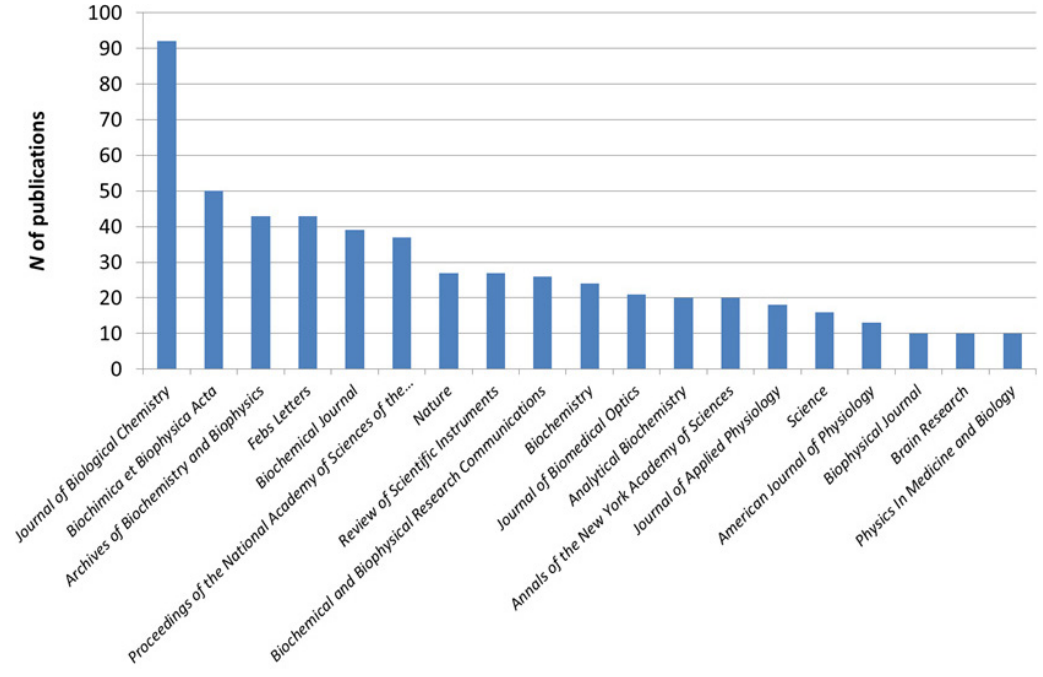
Fig. 6. Top journals with most publications from Britton